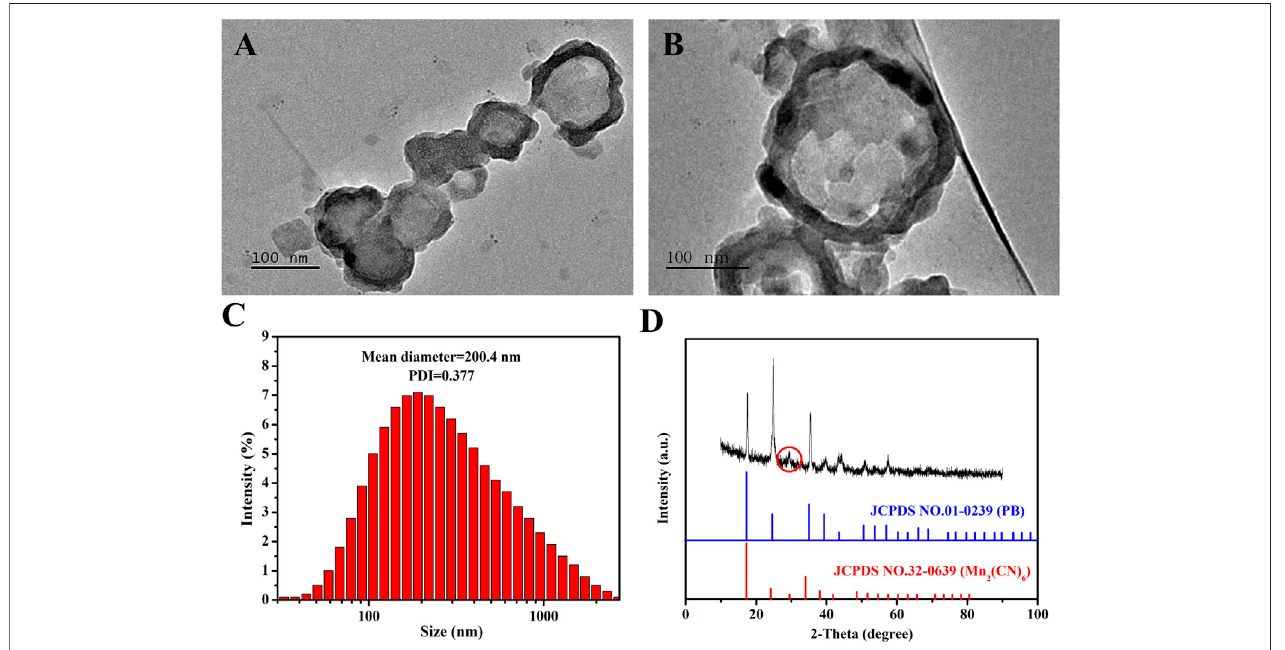
FIGURE 1 | The characterization of MnPB NPs. (A,B) TEM micrographs of MnPB NPs. (C) The hydrodynamic size of MnPB NPs. And the zeta potential of MnPB NPs is − 30.53 mV. (D) XRD patterns of as-synthesized MnPB